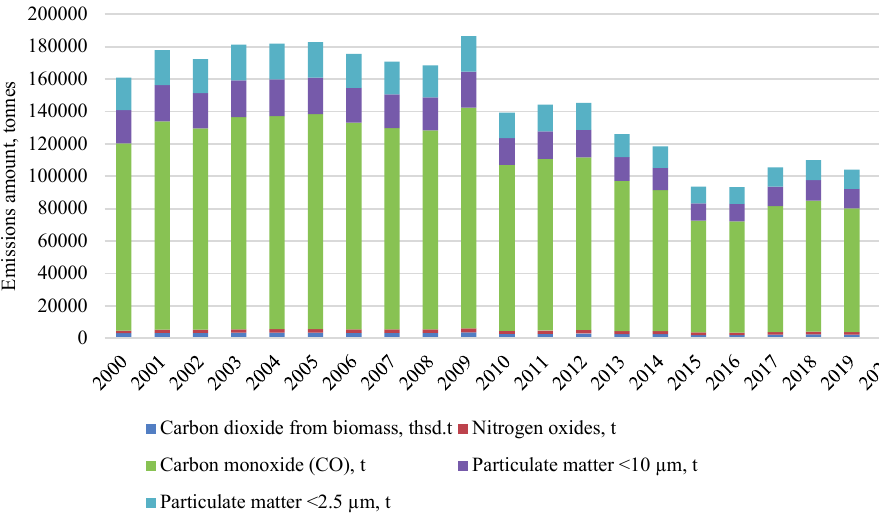
Fig. 1. The main emissions from household heating/cooling equipment in Latvia